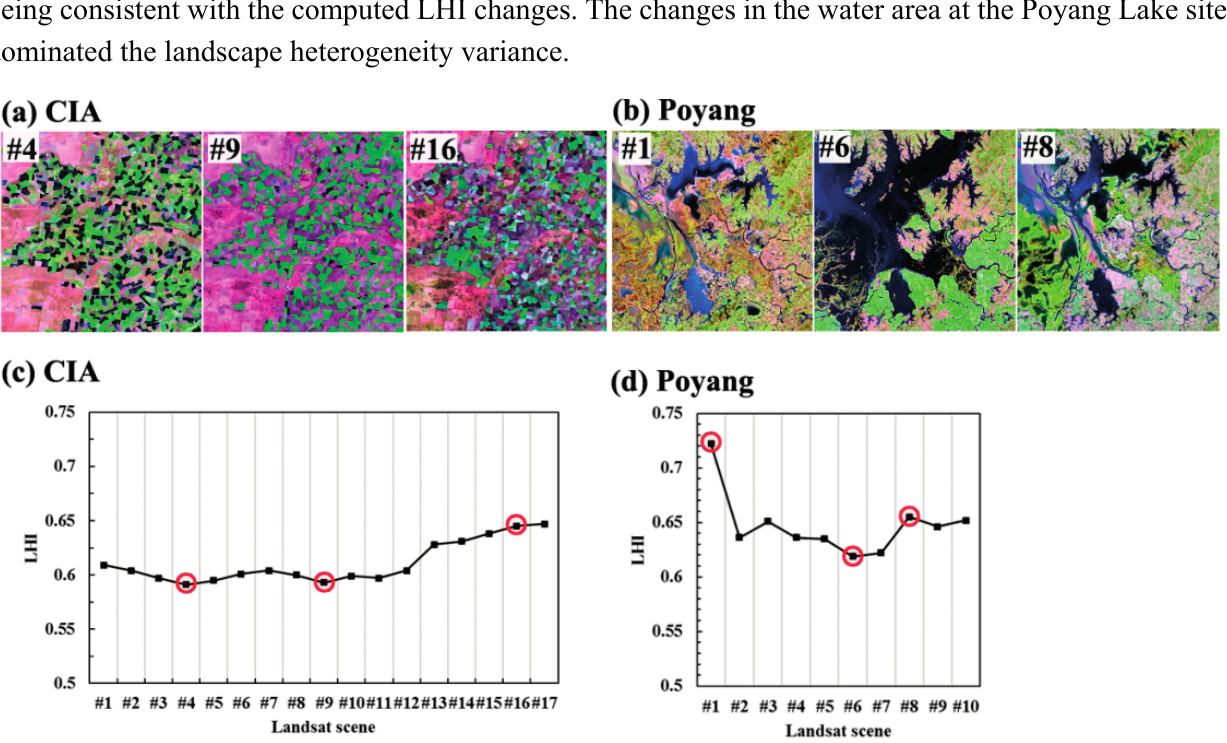
Figure 4. Selected Landsat scenes and time-series plots of landscape heterogeneity changes using the LHI. ( a ) ETM+ scenes of the CIA site acquired on 9 November 2001 (#4), 13 February 2002 (#9), and 27 April 2002 (#16); (b) TM scenes of the Poyang Lake site acquired on 15 February 2004 (#1), 26 September 2004 (#6), and 28 October 2004 (#8); ( c , d ) Time-series plots of the landscape heterogeneity using the LHI, indicating with red circles the specific images in (a,b), for the CIA site (c) and the Poyang Lake site